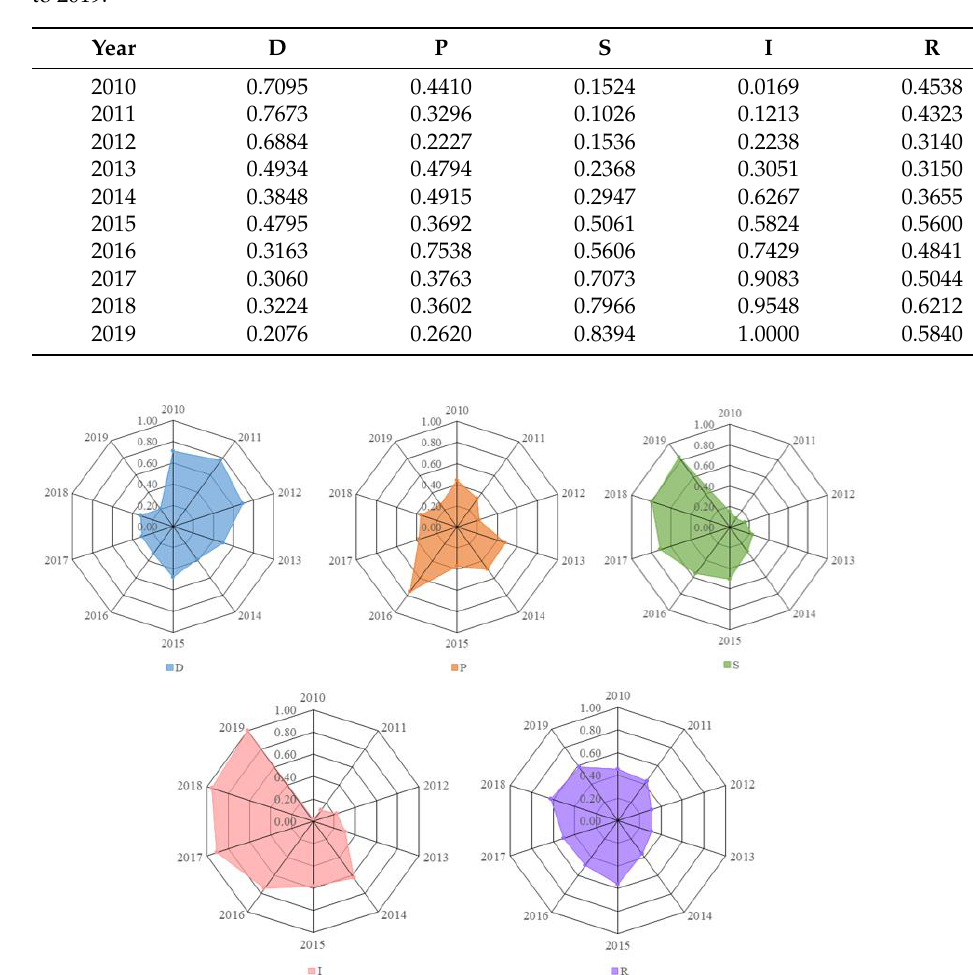
Figure 3. Change trend of subsystems of water resource carrying capacity in Zhengzhou from 2010 to 2019.